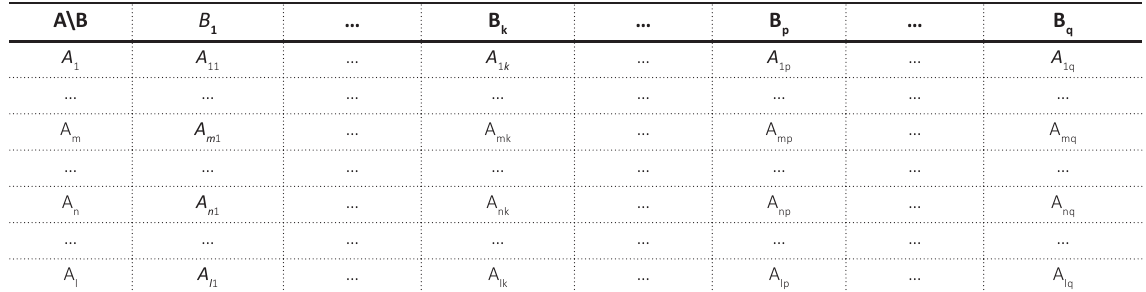
Table 1. Payment matrix A\B